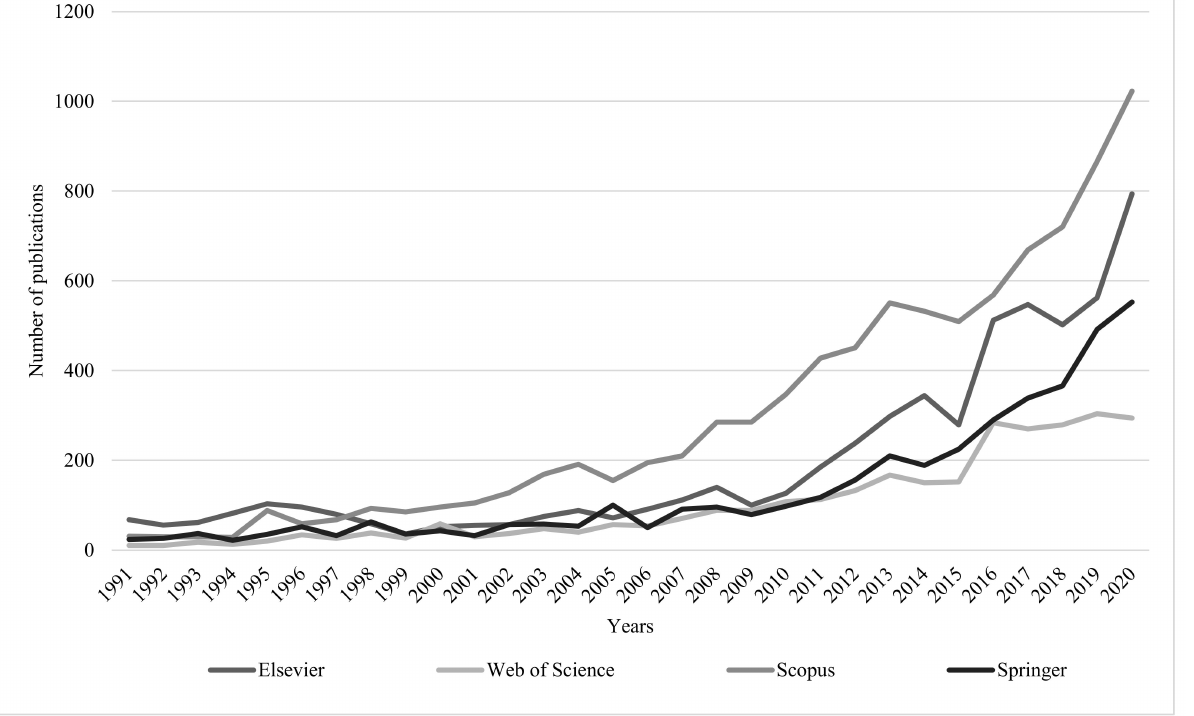
Figure 1. Number of publications on the topic urban transport published over the period 1991–2020 (status: 2 October 2021). Source: author’s